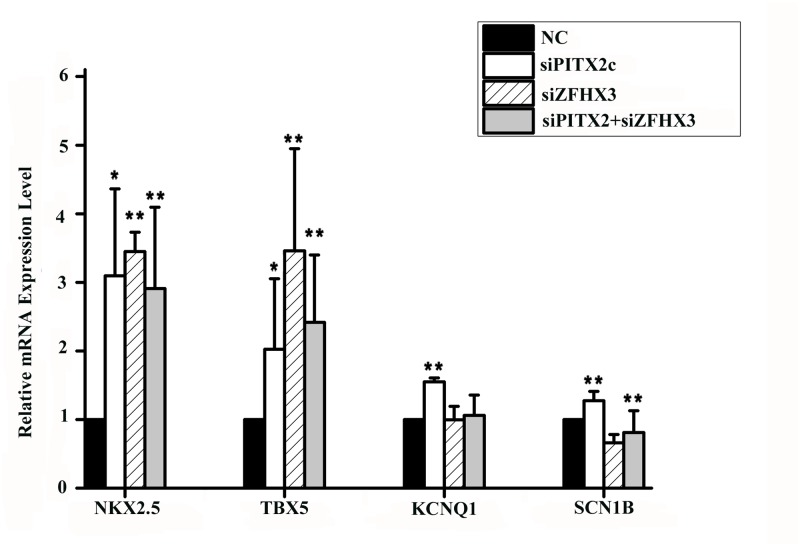

PITX2c and ZFHX3 regulate expression of NKX2.5, TBX5, KCNQ1 and SCN1B.HCT116 cells were transfected with siRNA specific for PITX2c or ZFHX3 and used for isolation of total RNA samples and real-time RT-PCR analysis. Transfection of siRNA for PITX2c increased expression of NKX2.5, TBX5, KCNQ1 and SCN1B. Transfection of siRNA for ZFHX3 increased expression of NKX2.5 and TBX5,but decreased expression of SCN1B. ZFHX3 did not affect on the expression of KCNQ1. Transfection of siRNAs for both PITX2c and ZFHX3 increased expression of NKX2.5 and TBX5.